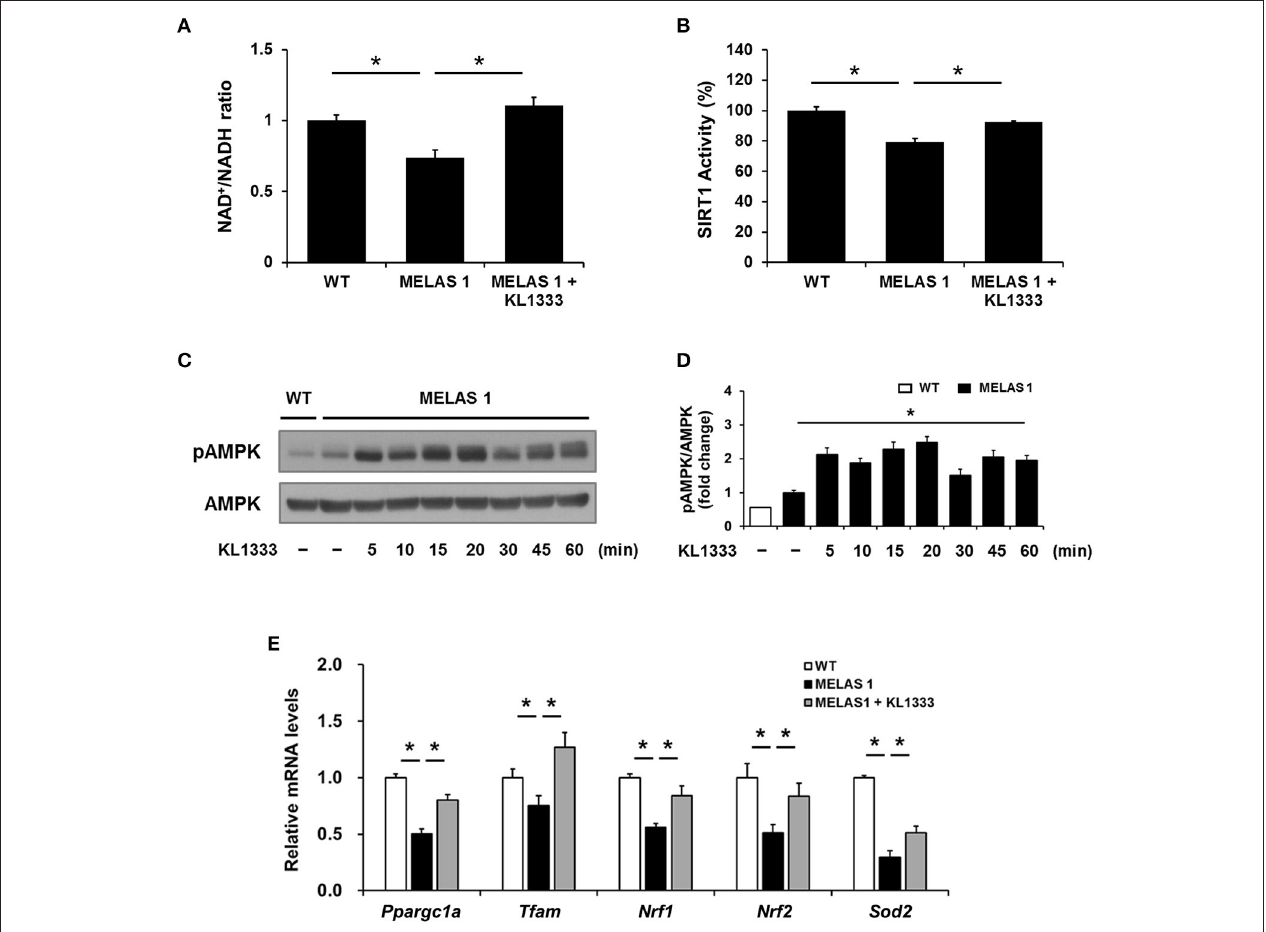
FIGURE 6 | KL1333 increases the NAD + /NADH ratio and activates SIRT1, AMPK, and PGC-1 α in MELAS fibroblasts. (A) MELAS 1 fibroblasts were treated with 1 µ M KL1333 for 30min lysed in extraction buffer, and intracellular ATP levels were measured. Intracellular NAD + and NADH were extracted, and NAD + and NADH levels were measured using a microplate reader. The NAD + /NADH ratio was calculated based on the concentration of NAD + and NADH. (B) MELAS 1 fibroblasts were treated with 1 µ M KL1333 for 30min. SIRT1 activity was analyzed using a fluorescence-based assay. (C) MELAS 1 fibroblasts were treated with 1 µ M KL1333 for the indicated times. The activity of AMPK was examined by Western blotting using the indicated antibodies. (D) Quantification of pAMPK levels in MELAS 1 fibroblasts using its band density normalized to that of total AMPK. (E) MELAS 1 fibroblasts were treated with 1 µ M KL1333 for 24h. The expression of PGC-1 α and its target genes were measured by real-time PCR using specific primers for Ppargc1a , Tfam , Nrf1 , Nrf2 , and Sod2 . Each experiment was repeated three times. Error bars indicate ± SEM. * P < 0.05.